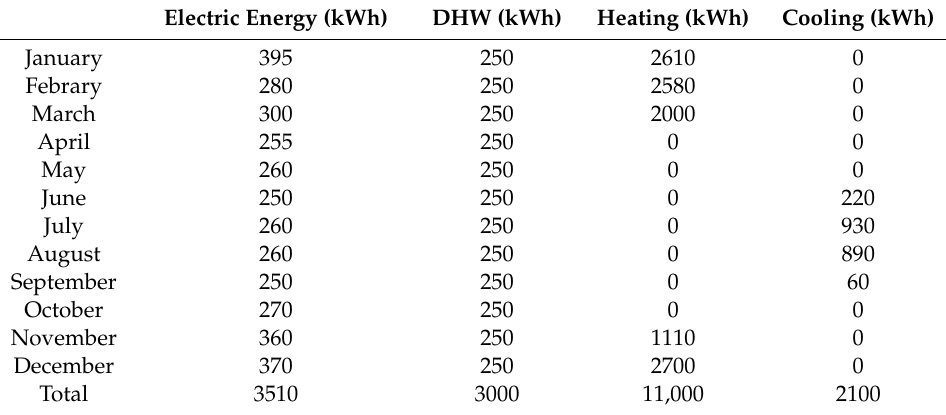
Table 2. Energy demands of the user during the